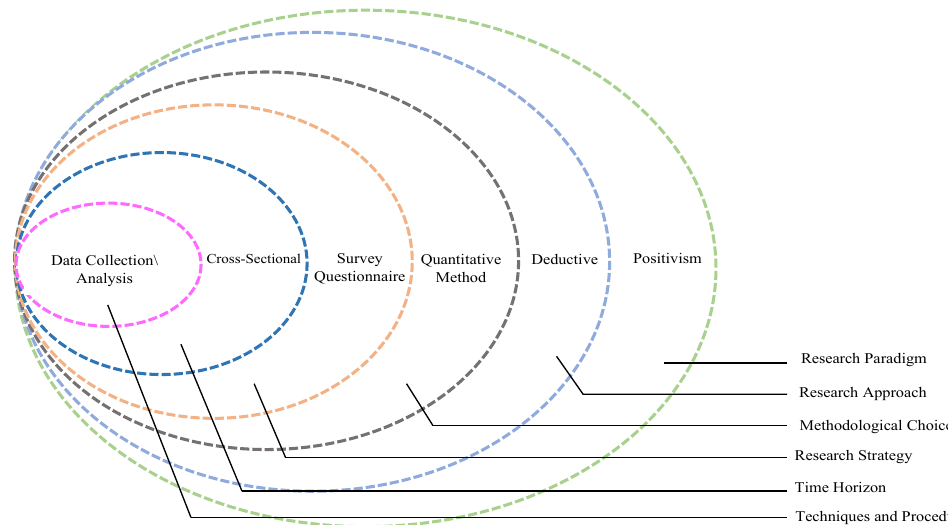
Figure 1. Present research design adapted from Saunders et al. (2016).